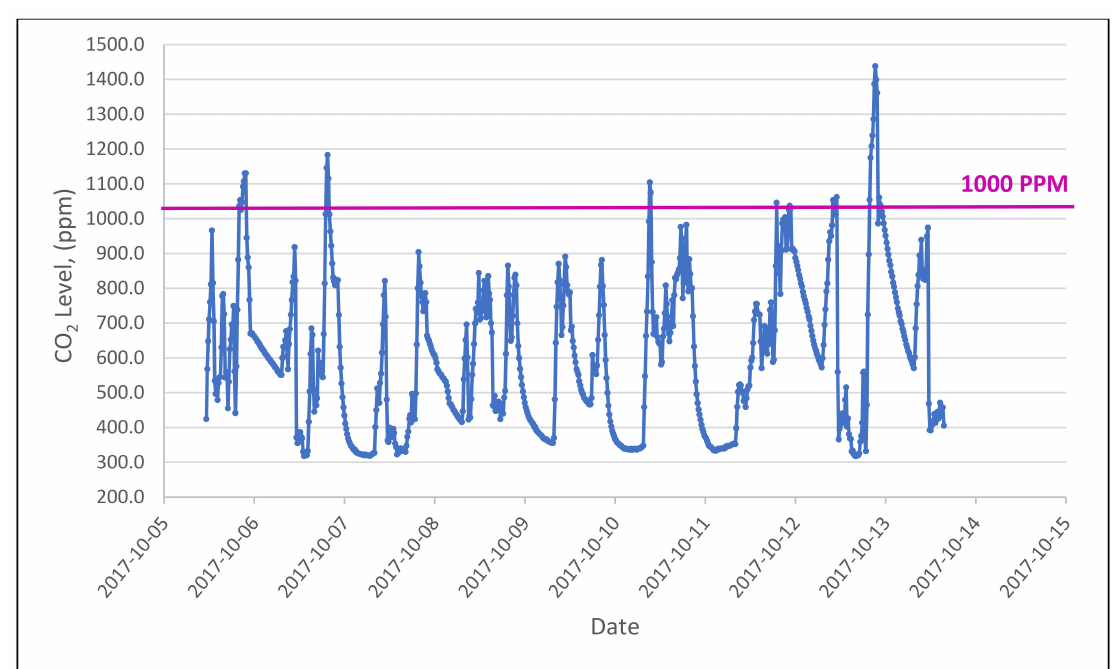
Figure 8. Measured carbon dioxide concentration inside the house.